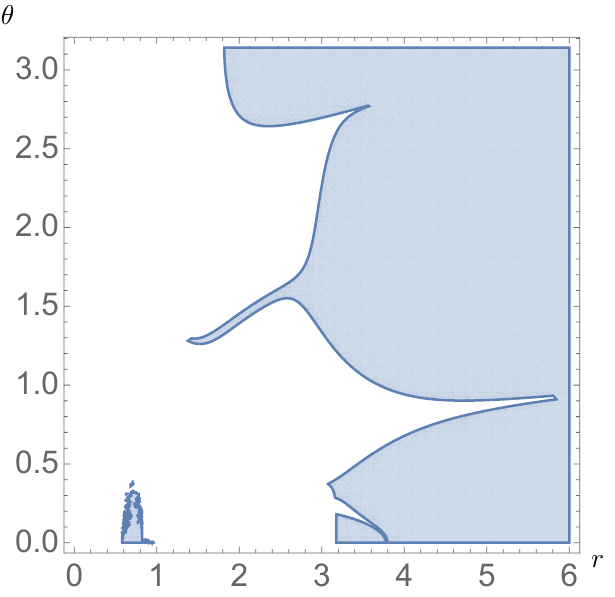
Figure 1 . Mass for variations (cid:14)A , (cid:14)g and (cid:14)(cid:30) . Blue regions indicate that all mass are positive, while white regions are related to tachyonic